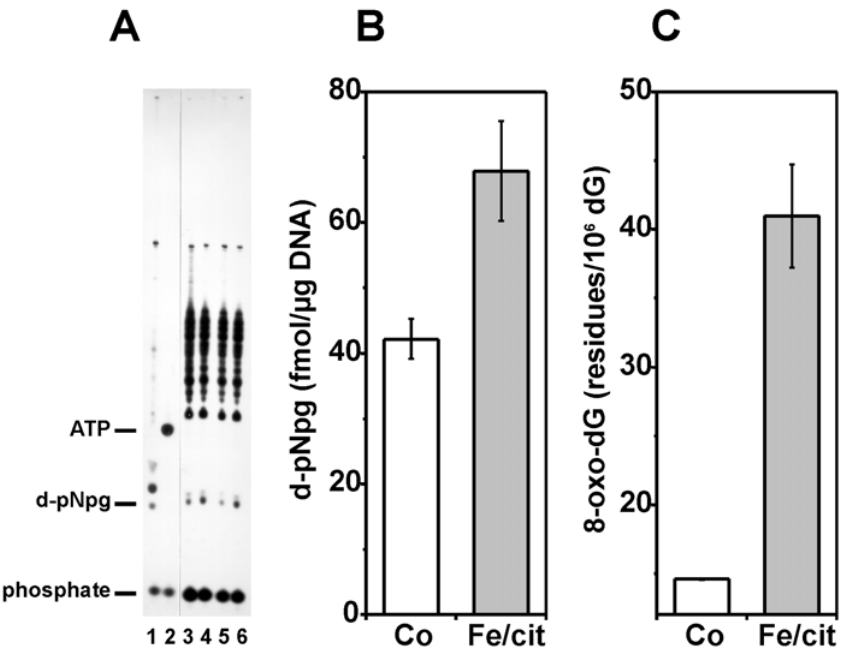
Fig. 3 – Formation of 3’-phosphoglycolate termini in DNA from Fe 2+ -citrate-treated mitochondria. Panel A : A typical autoradiogram of mtDNA processed by the 32 -P-postlabeling assay. Controls: irradiated calf thymus DNA (lane 1) and ATP alone (lane 2). mtDNA from RLM incubated in the presence of 1 mM EGTA (lanes 3 and 5) and 50 µ M Fe 2+ and 2 mM citrate (lanes 4 and 6). Panel B : Quantification of the deoxynucleoside 5’-phosphate, 3’-phosphoglycolate (d-pNpg) bands. Panel C : Quantification of the levels of 8-oxo-dG. mtDNA was obtained from RLM incubated in the presence of 1 mM EGTA (Co) and 50 µ M Fe 2+ and 2 mM citrate (Fe/cit). Results represent mean value ± SEM of four independent